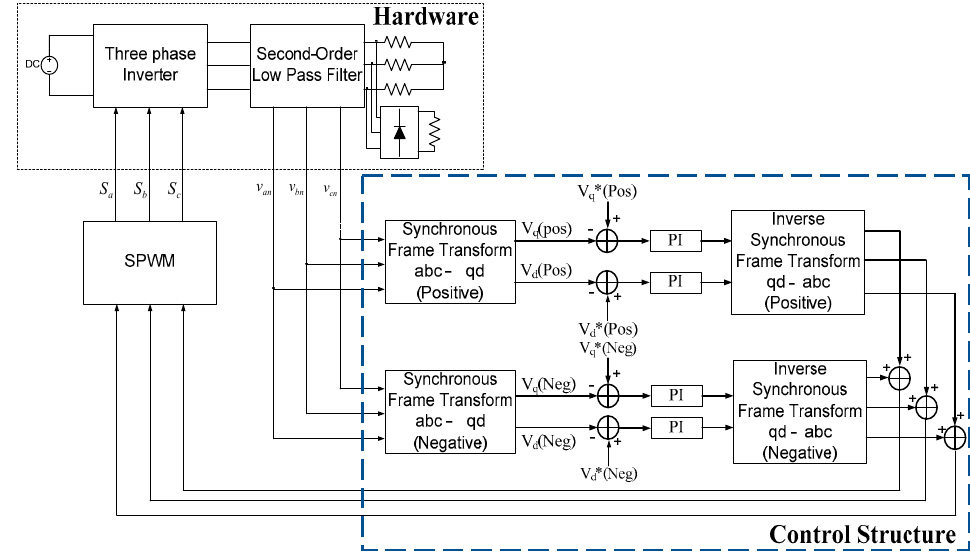
Figure 2. The conventional structure for unbalance component compensation.